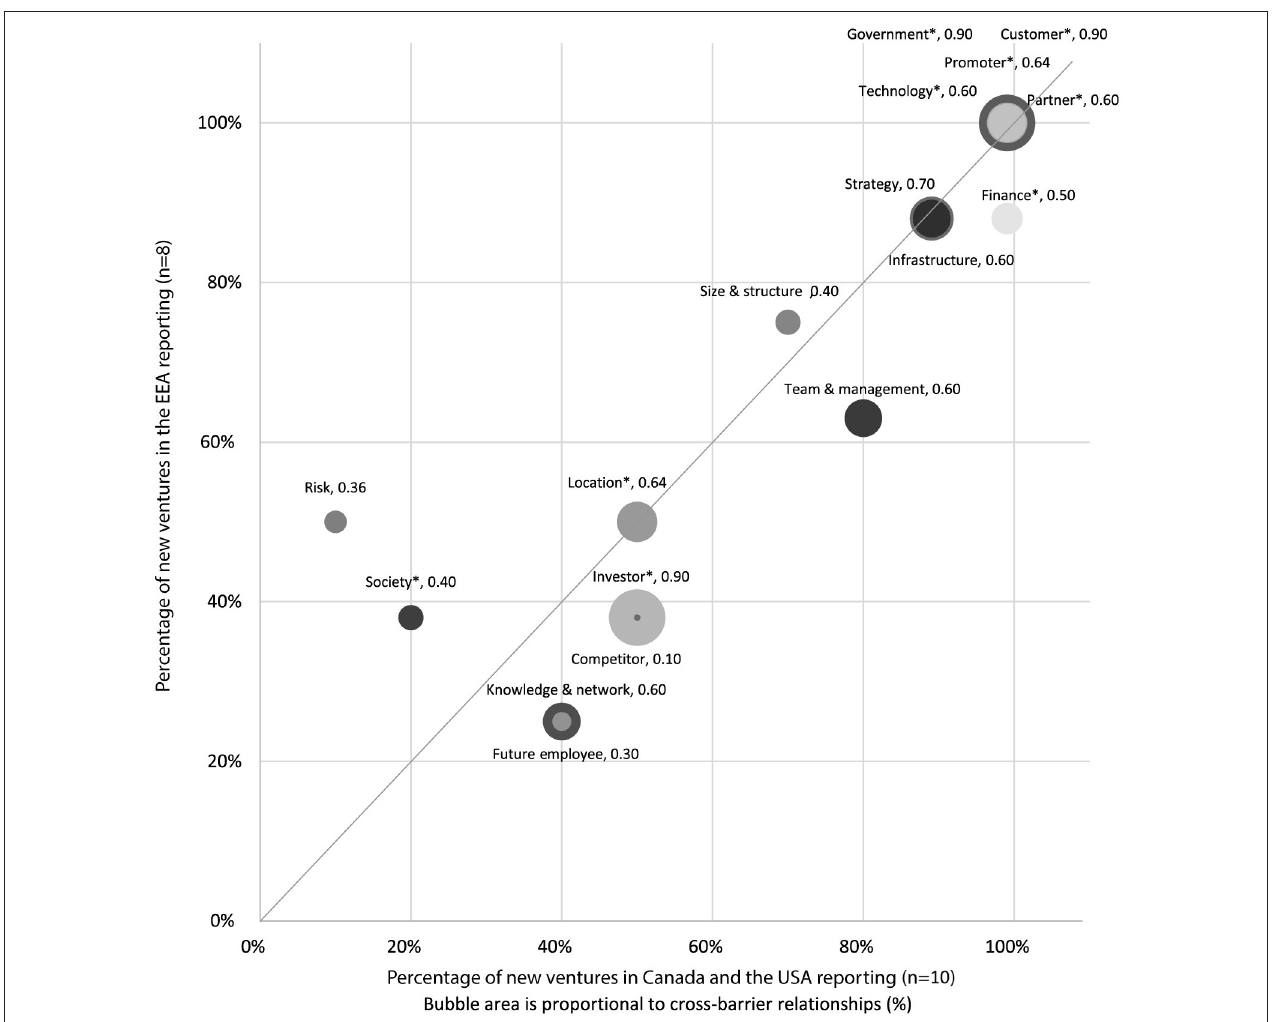
FIGURE 5 | Reported barrier category matrix: Canada and USA vs. EEA. *Perceived main barrier reported in category.